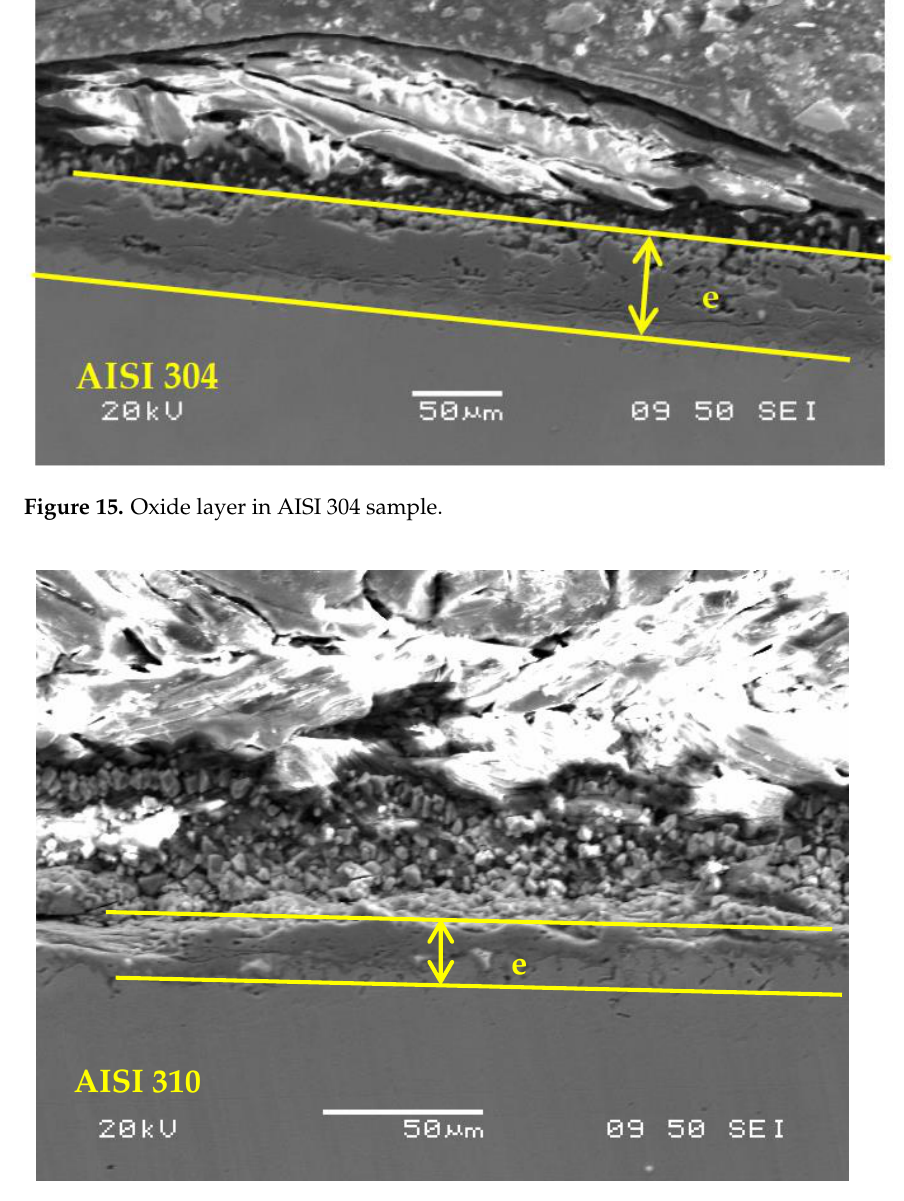
Figure 16. Oxide layer in AISI 310 sample. Table 3. Atomic weight of elements.